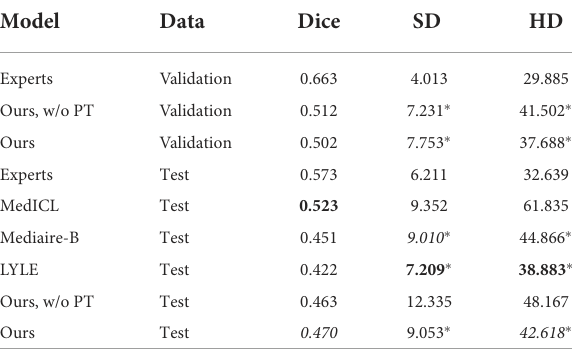
TABLE 2 New lesion segmentation results for medical experts, our proposed method with and without pre-training (PT) as well as the three approaches performing best in the MSSEG-2 challenge (Ashtari et al., 2021; Dalbis et al., 2021; Zhang et al., 2021).